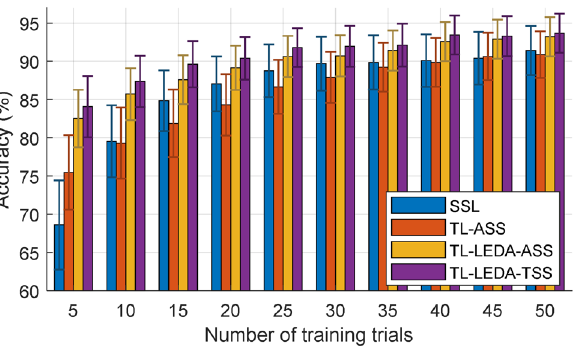
Figure 8. Averaged classification accuracies across all subjects of the four algorithms varying with the number of training trials, which ranges from 5 to 50 with the interval of 5 trials. The error bars represent the standard error.